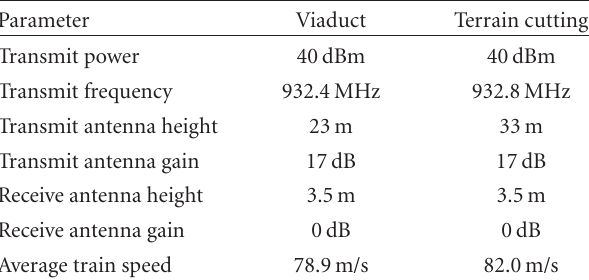
Table 1: Measurement